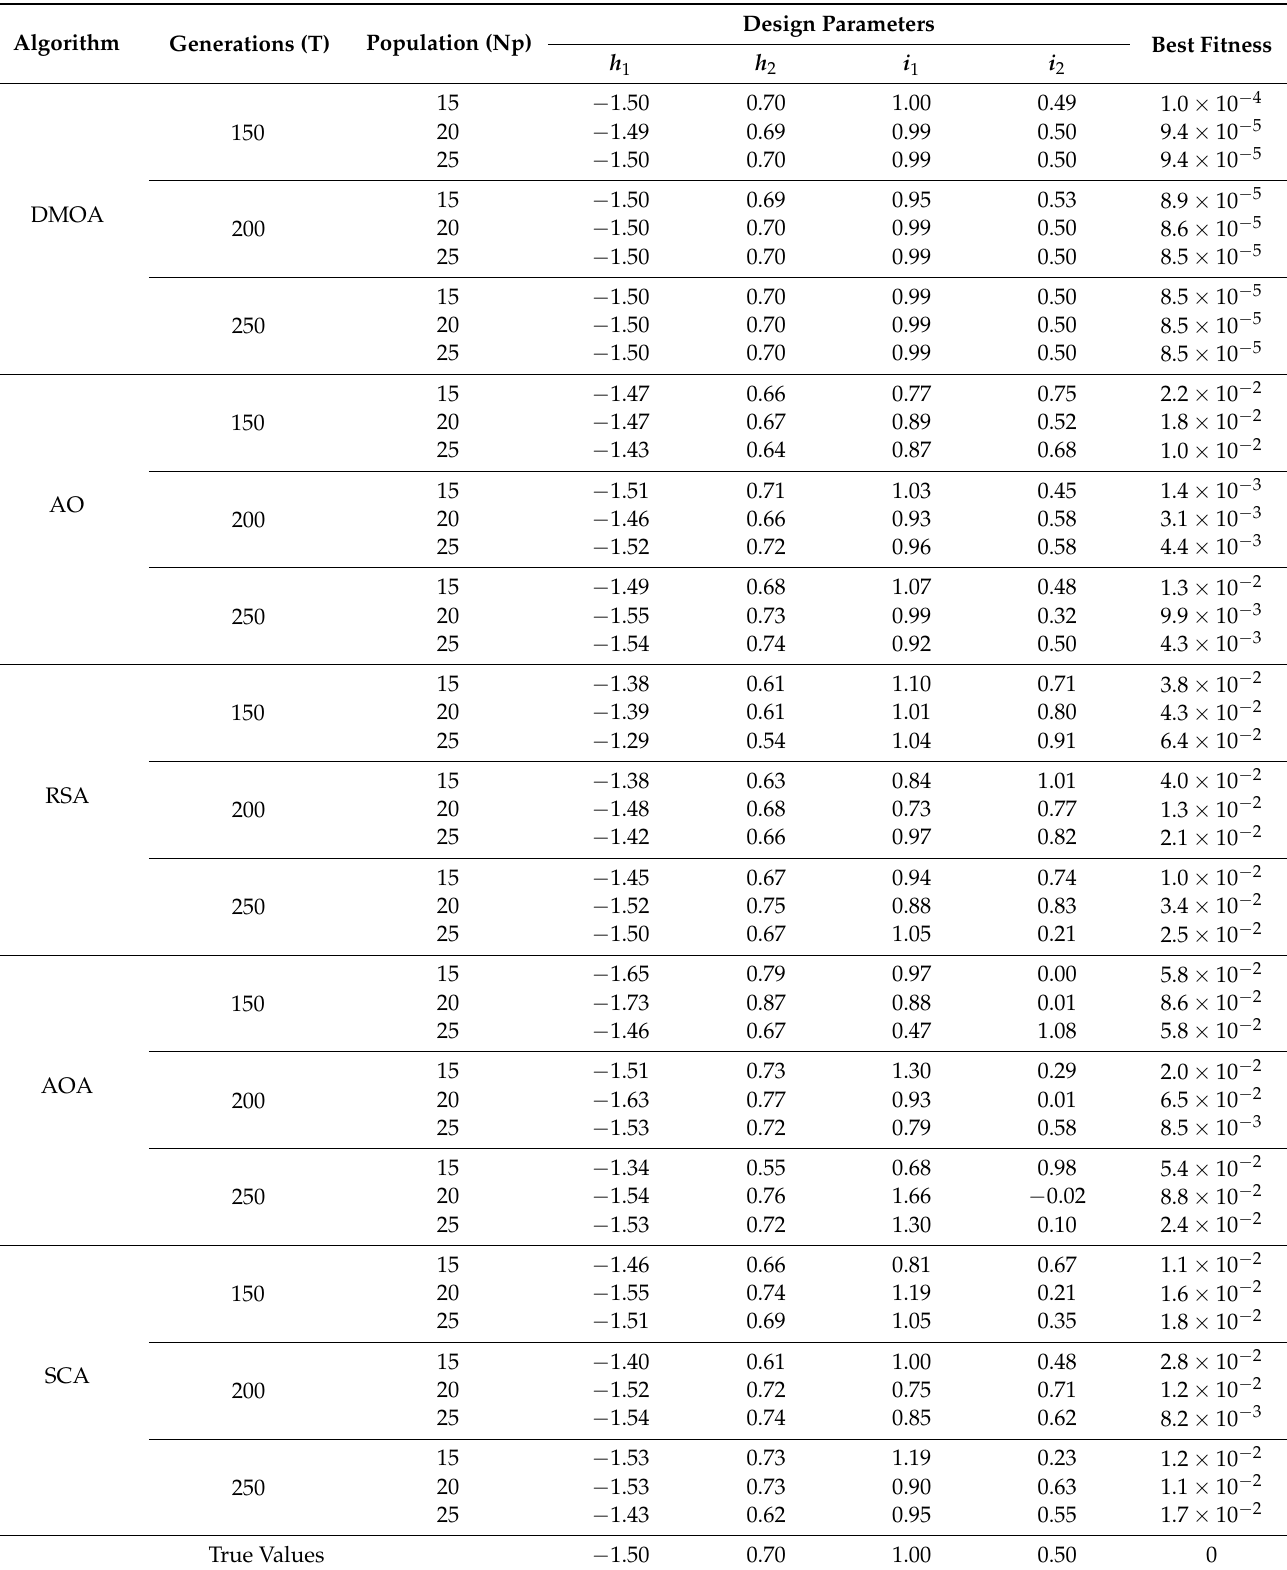
Table 6. Comparison of the DMOA with the AO, RSA, AOA and SCA against true values for the ARX model at 0.01 noise